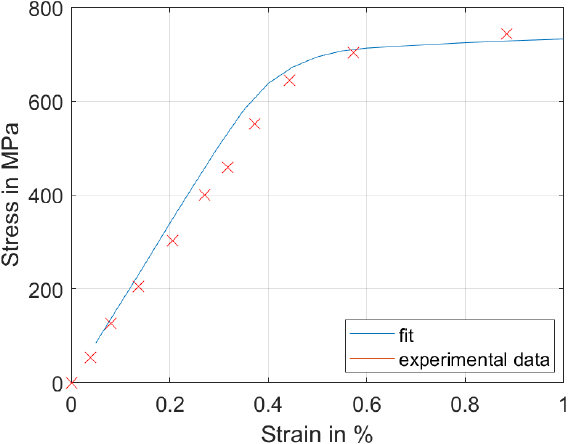
Figure 1. Experimental stress-strain data for IN-738 LC at 850 °C [24] and corresponding fitted elastic plastic polycrystalline model.